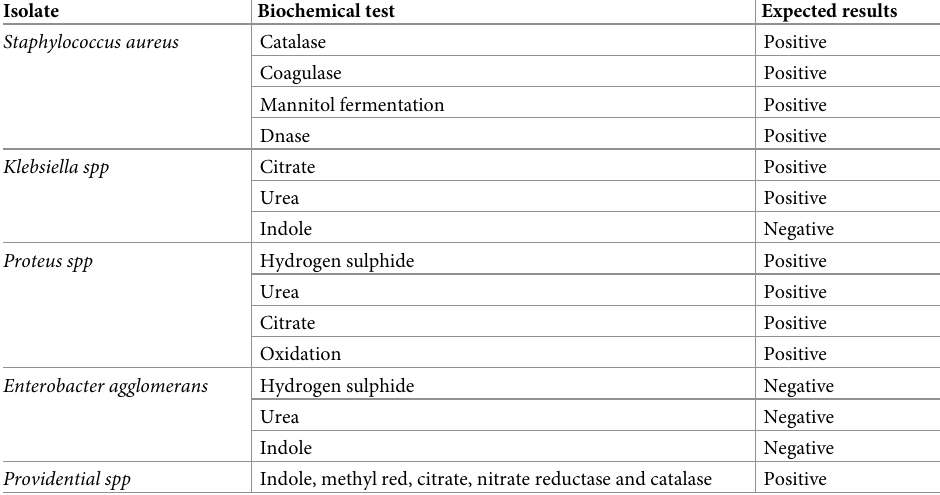
Table 1. Biochemical tests for identification of bacterial